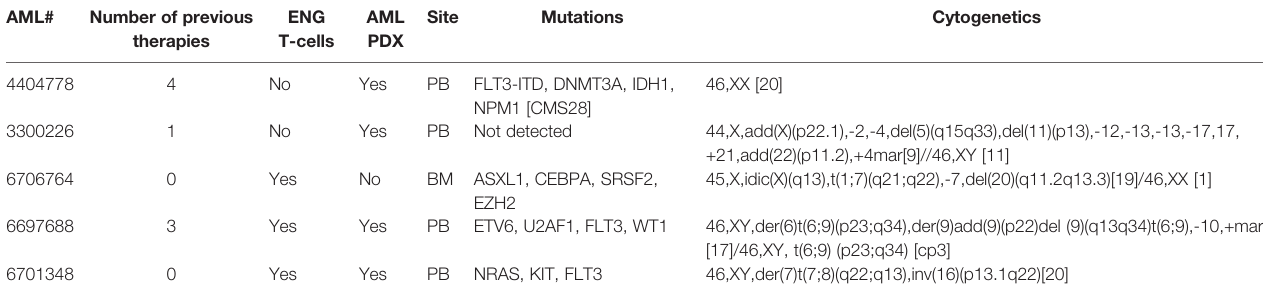
TABLE 1 | Primary CD123-positive AML patient